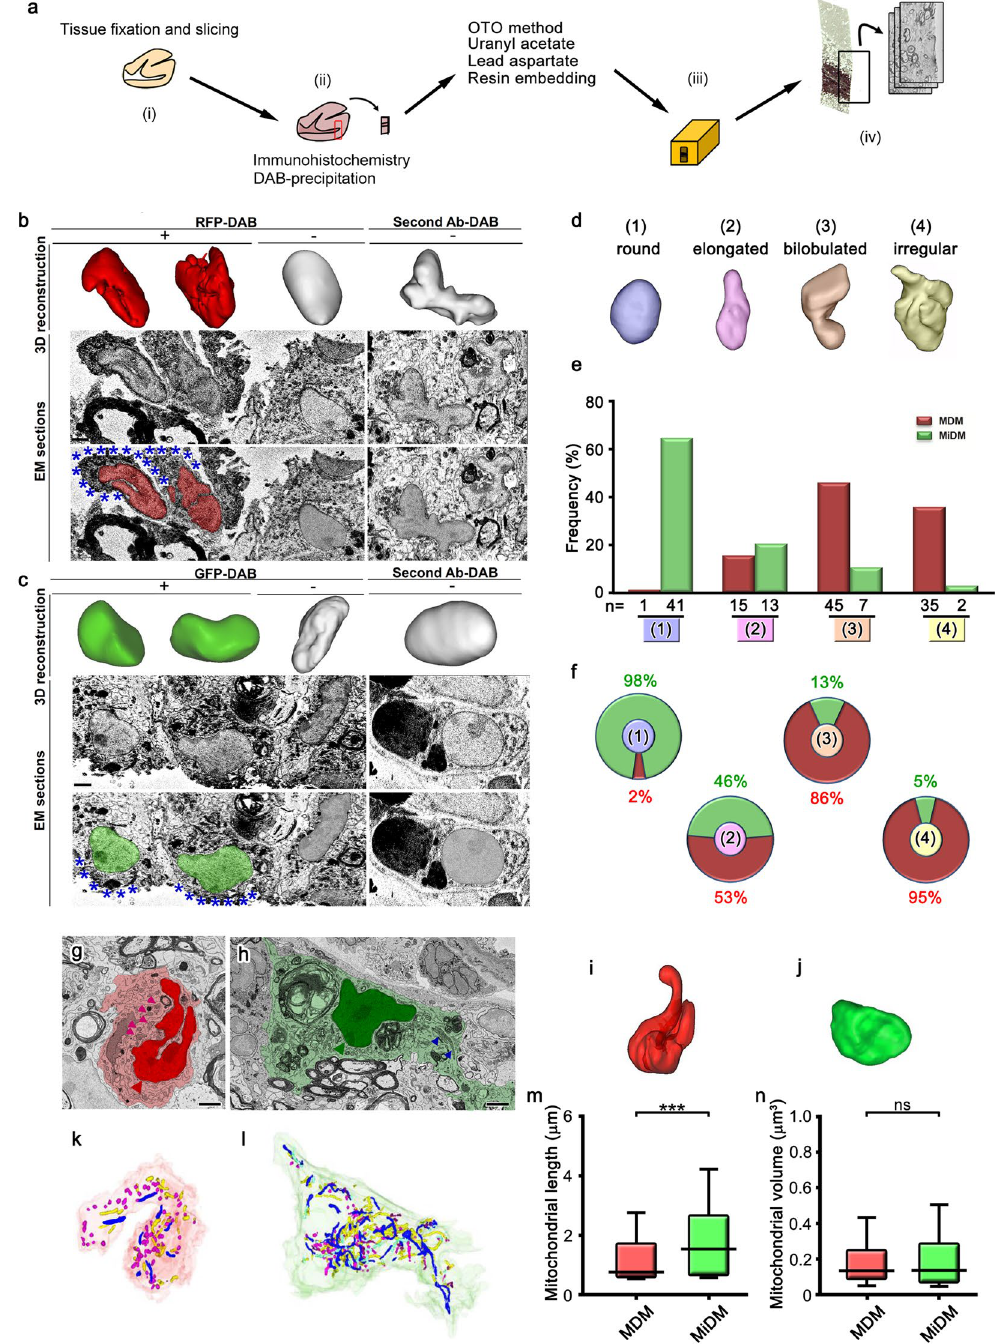
Figure 1. Longer mitochondria and round nuclei of microglia-derived macrophages in spinal cord tissues at the onset of experimental autoimmune encephalomyelitis. ( a ) After fixation and slicing (i), brain tissues were immunostained with DAB (ii), and embedded in resins ( a , iii). Serial images were acquired for 3D reconstruction ( a , iv). Reconstruction of nuclei (upper panels) and original immunoelectron microscopic images (middle, lower panels) of RFP- ( b , red) and GFP- ( c , green) positive cells in the spinal cord of a Ccr2 rfp/ + :: Cx3cr1 gfp/ + mouse with DAB deposits ( b,c , asterisks). The nuclei of DAB negative cells (center) and immunocontrols (right) are also shown. The grading ( d ) and counting ( e , f ) of nuclear shapes in the RFP- positive monocyte-derived macrophages (MDM) and GFP-positive microglia-derived macrophages (MiDM). Single images ( g,h ) and nuclear ( i,j ) and mitochondrial ( k,l ) 3D reconstructions of MDM ( g,k,i , red) and MiDM ( h,j,l , green) are shown. Mitochondria are indicated ( g , h , arrowheads). Long and short mitochondria are colored in blue and magenta, respectively ( k,l ). The mitochondrial length ( m ) and volume ( n ) of MiDM and MDM are compared. ns: not significant. *** p < 0.001 in the U -test. N = 648 or 786 for mitochondria in MDM or MiDM. Bars: 2 μ